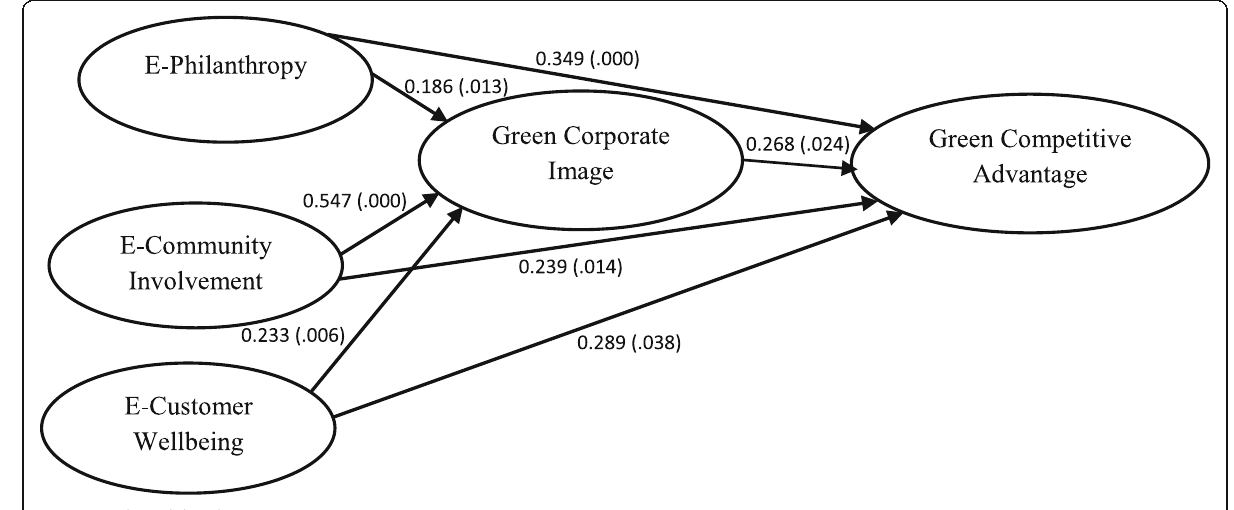
Fig. 2 Final Model with Parameter